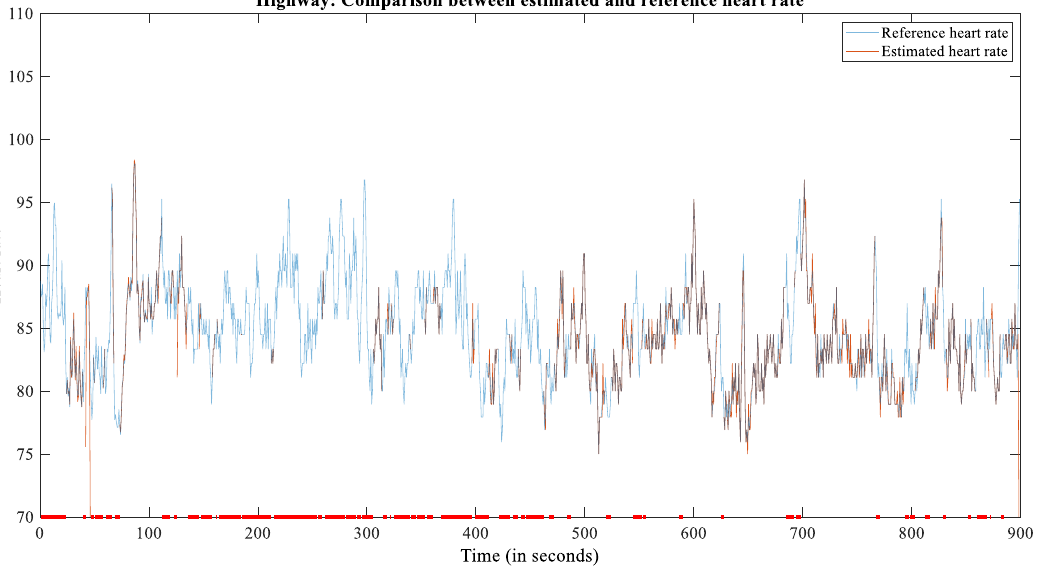
Figure 7 . The plot of reference and estimated HR for subject 2209 during the highway scenario. On rural roads, the SNR was lowest (Figure 8). In total, 136 min out of 285 min (47.72%) were labeled as usable.